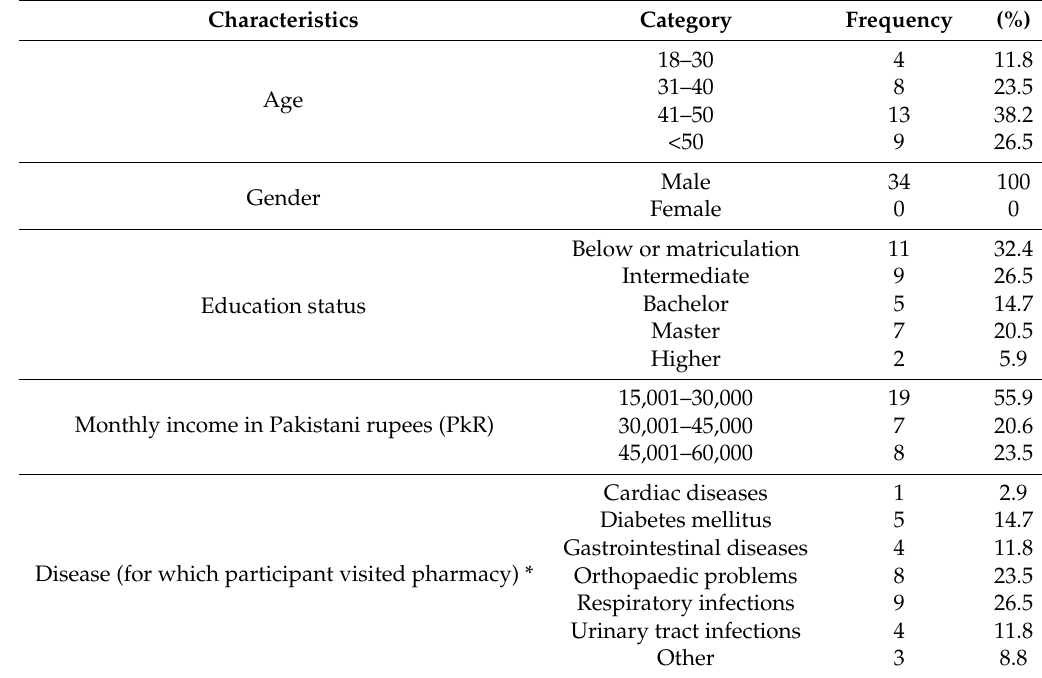
Table 1. Social demographics of study